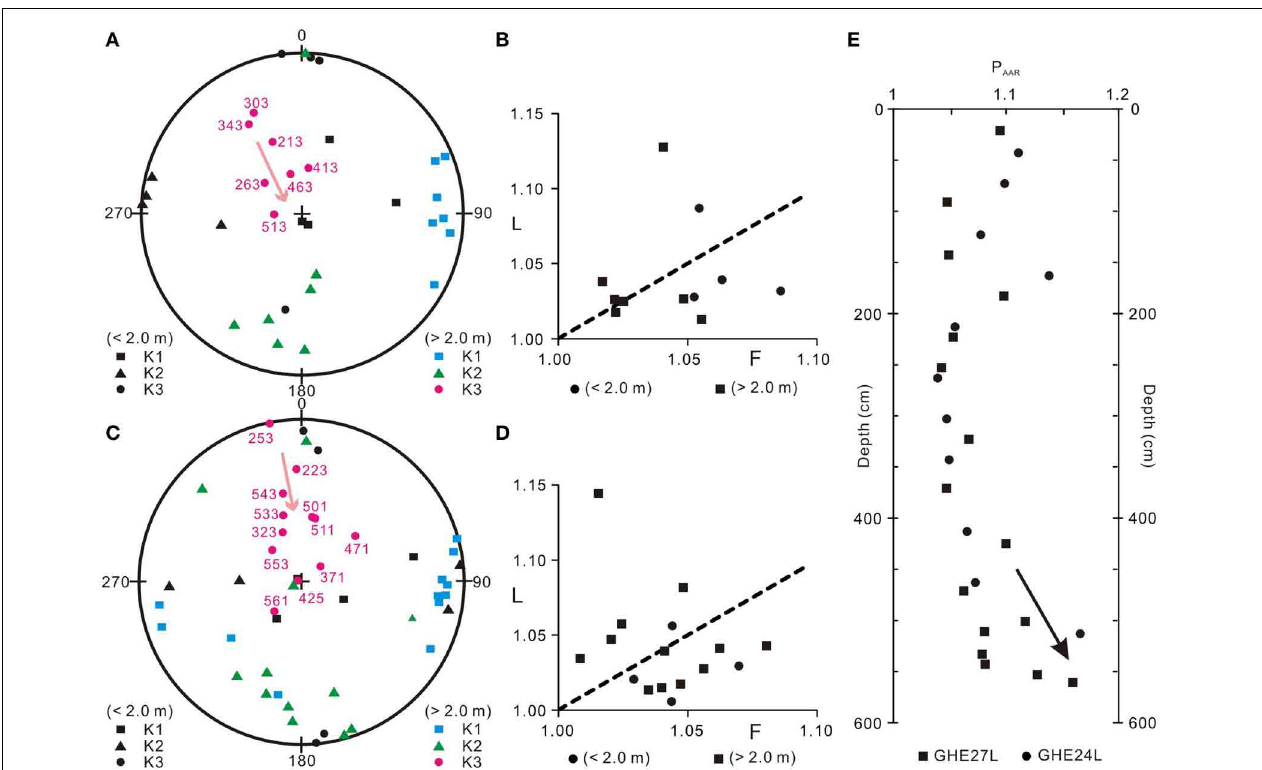
FIGURE 4 | Anisotropy of anhysteretic remanence (AAR) data of Core GHE24L (A,B) and GHE27L (C,D) and the down-core variations in the magnitude of AAR of the two cores (E). The upper 2m sediments show non-bedding parallel foliated AAR fabrics (A,C) and the > 2m sediments exhibit a weak, predominantly foliated fabrics (A,C) . Pink arrows in (A,C)